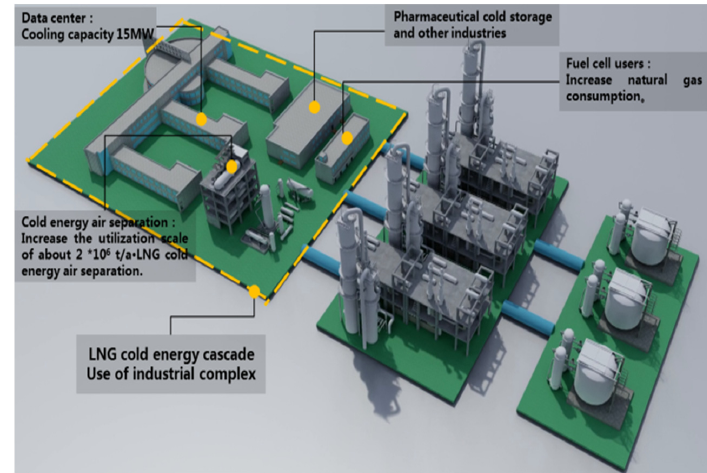
Figure 11. Schematic diagram of LNG cold energy industry layout.